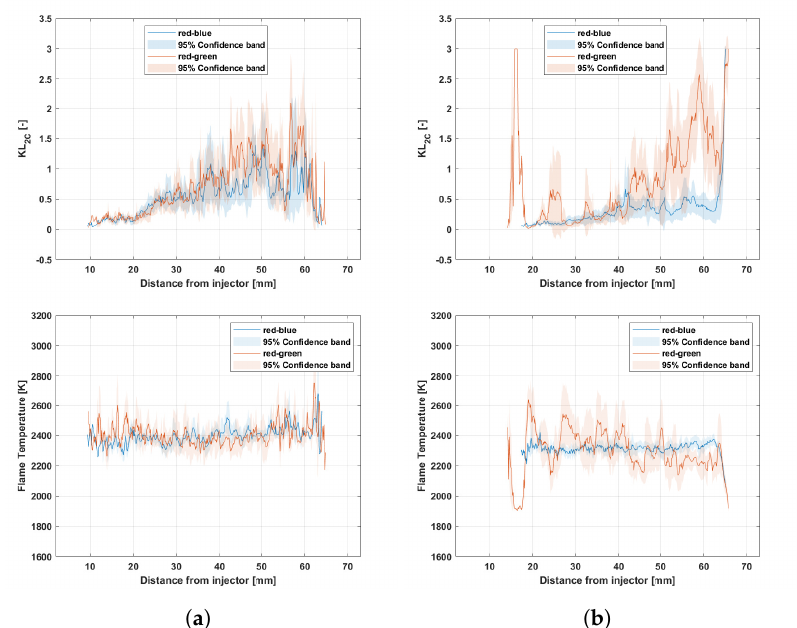
Figure 13. Comparison of KL 2 C and temperature values for the two filter combinations. t = 2900 µ